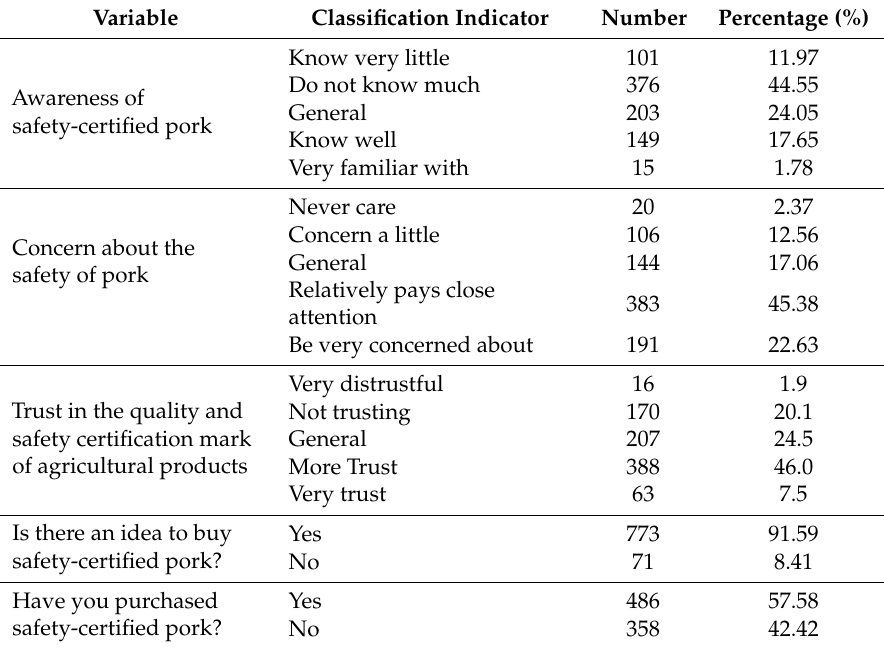
Table 3. The consumers’ cognition and consumption of safety-certified pork.